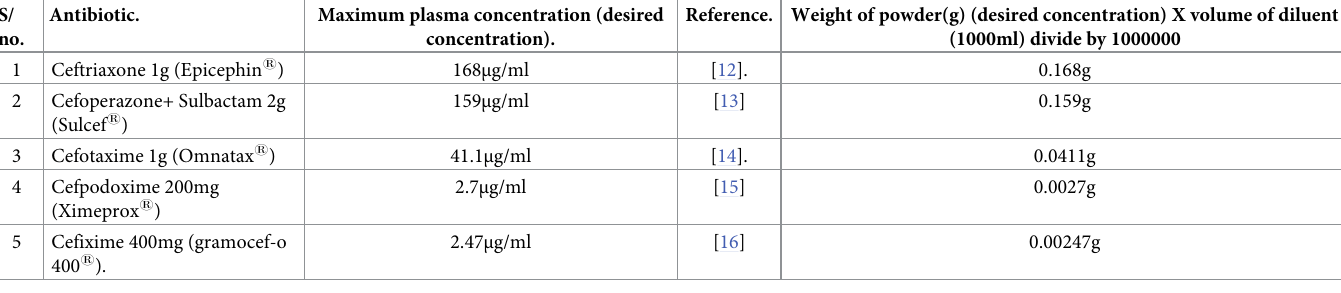
Table 2. Weight of powder for stock solutions. S/ Antibiotic. Maximum plasma concentration (desired no.